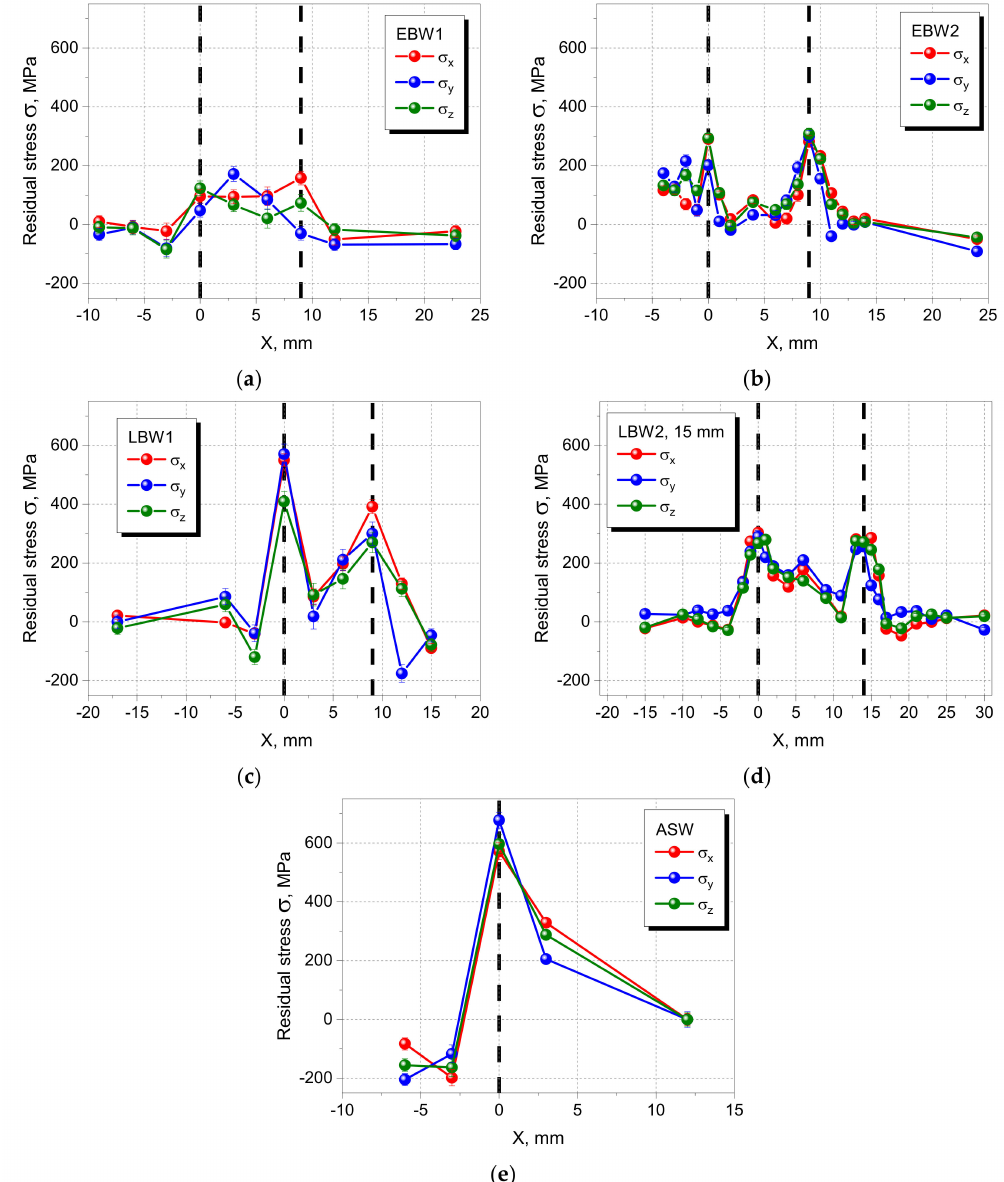
Figure 3. Residual stress distributions vs. scan coordinate X in test Charpy specimens reconstituted by various welding techniques. Specimens studied: EBW1 ( a ), EBW2 ( b ), LBW1 ( c ), LBW2 ( d ) and ASW ( e ). Centers of weld seams are at X = 0 and X = 9 mm (X = 14 mm for LBW2), except ASW specimen with one weld seam at X = 0 mm. Thick vertical dash lines indicate weld seams